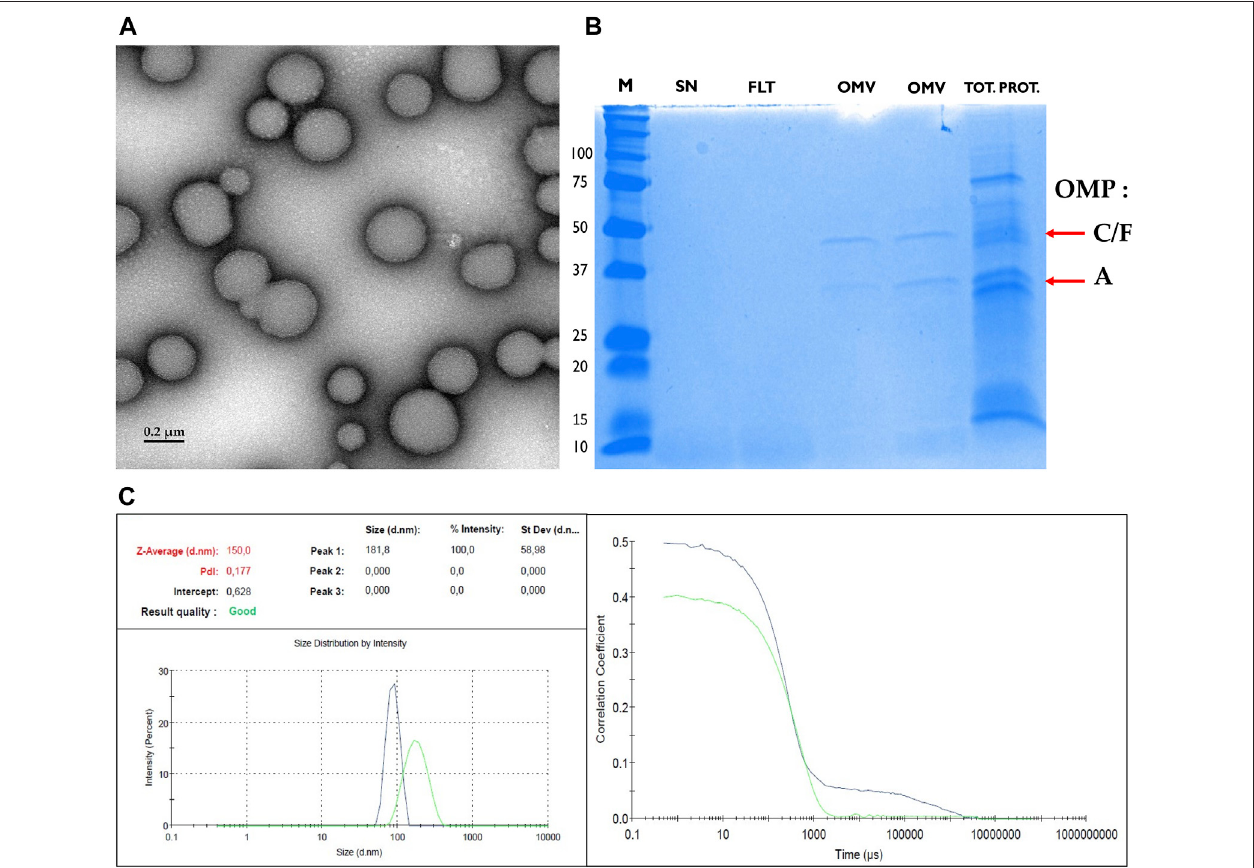
FIGURE3| Biophysical characterizationofOMVs. (A) Transmission electron microscopy image ofpuri fi ed E.coli outer membrane vesicle (OMV) showing sizeand morphology.Scalebar,200 nm. (B) Coomassieblue-stainedSDS-PAGEofOMVsfromculturesof E.coli K12MG1655showssuccessfulpuri fi cationofOMVsdepleted from cellular debris. From left to right we illustrate the molecular weight ladder (M, in kDa), the supernatant (SN), the fi ltrate (FLT), two samples of OMV: the fi rst being isolated using ultracentrifugation approach and the second using the Exobacteria kit, and at the very right the total protein fraction (TOT. PROT.). The successful enrichmentofOMVswiththeultracentrifugationortheExobacteriakitwascon fi rmedbythepresenceoftwobandswhichwereveri fi edtocorrespondtothemajorOuter Membrane Proteins (OMPs) and OMV marker proteins OmpF/C (40 kDa) and OmpA (35 kDa) (Horstman and Kuehn, 2000; Daleke-Schermerhorn et al., 2014). The positions ofOMPs F, C, and A areindicated by red arrows. (C) Dynamic Light Scattering analysis ofthe hydrodynamic size of E. coli OMVs. The Intercept value: 0.628 = the signal-to-noise ratio = ideal signal between = (0.6 – 1); the Polydispersity Index (PdI): 0.177 = diversity of size distribution = indicate if samples are suitable or not: (0.05 – 07); The Z-average :150 = hydrodynamic parameter insensitive to noise = average size of a particle size